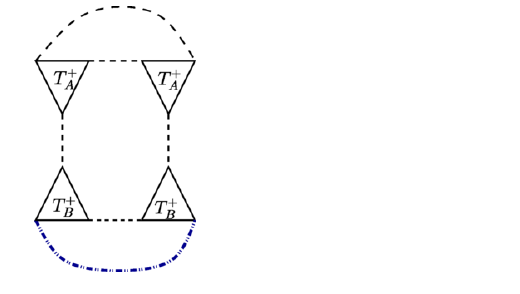
Figure 12 . Construction of genus three theory with G max = u (1) 2 su